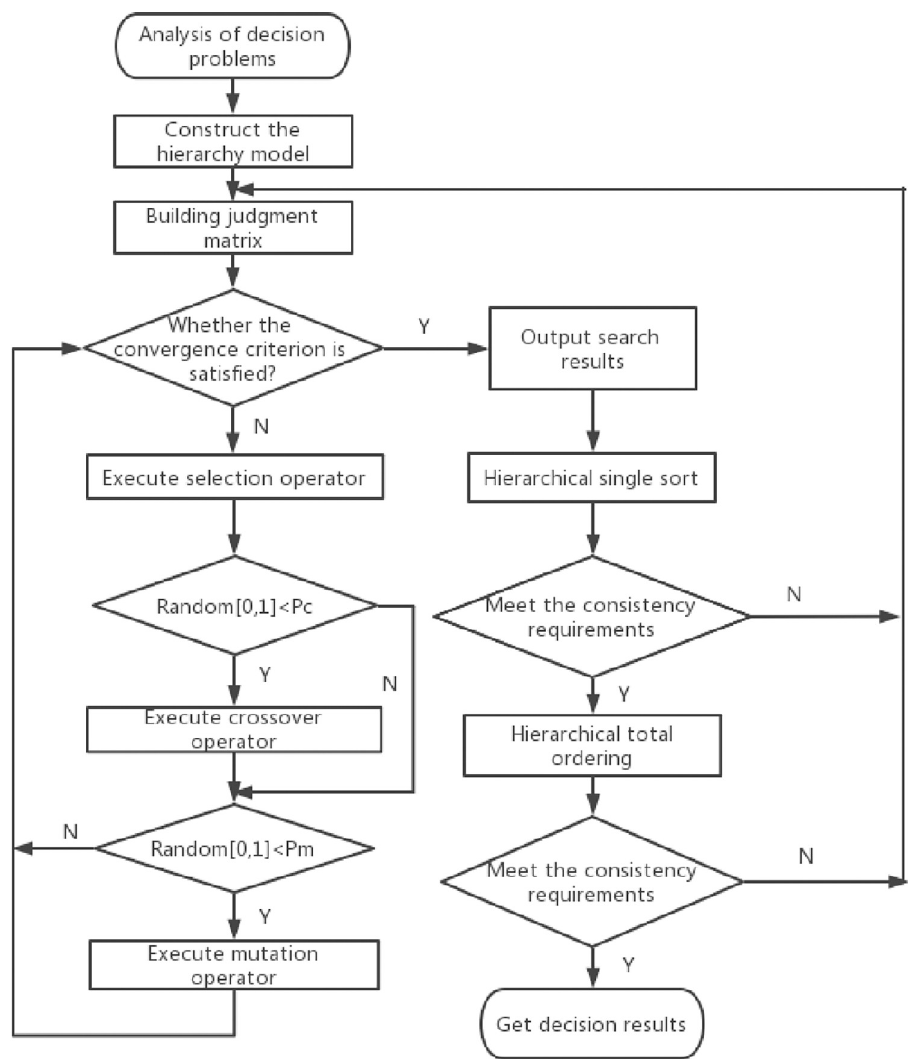
Fig 2. Optimized flow